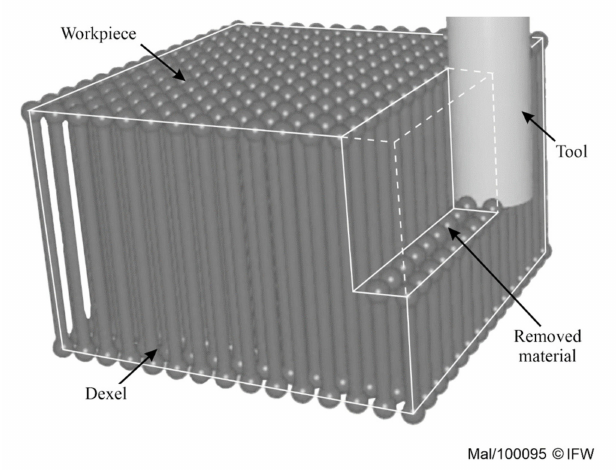
Figure 1. Dexel-based simulation of a milling